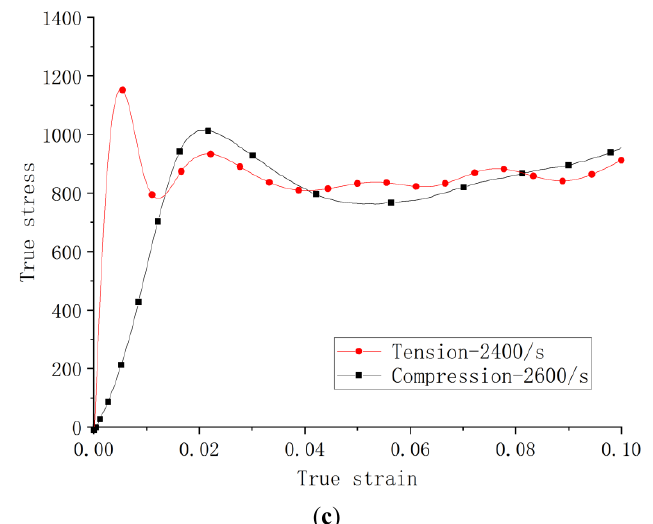
Figure 14. Stress–strain curves of ( a ) compression and tension at 900 s − 1 , ( b ) compression at 1300 s − 1 and tension at 1400 s − 1 , and ( c ) compression at 2600 s − 1 and tension at 2400 s − 1 .